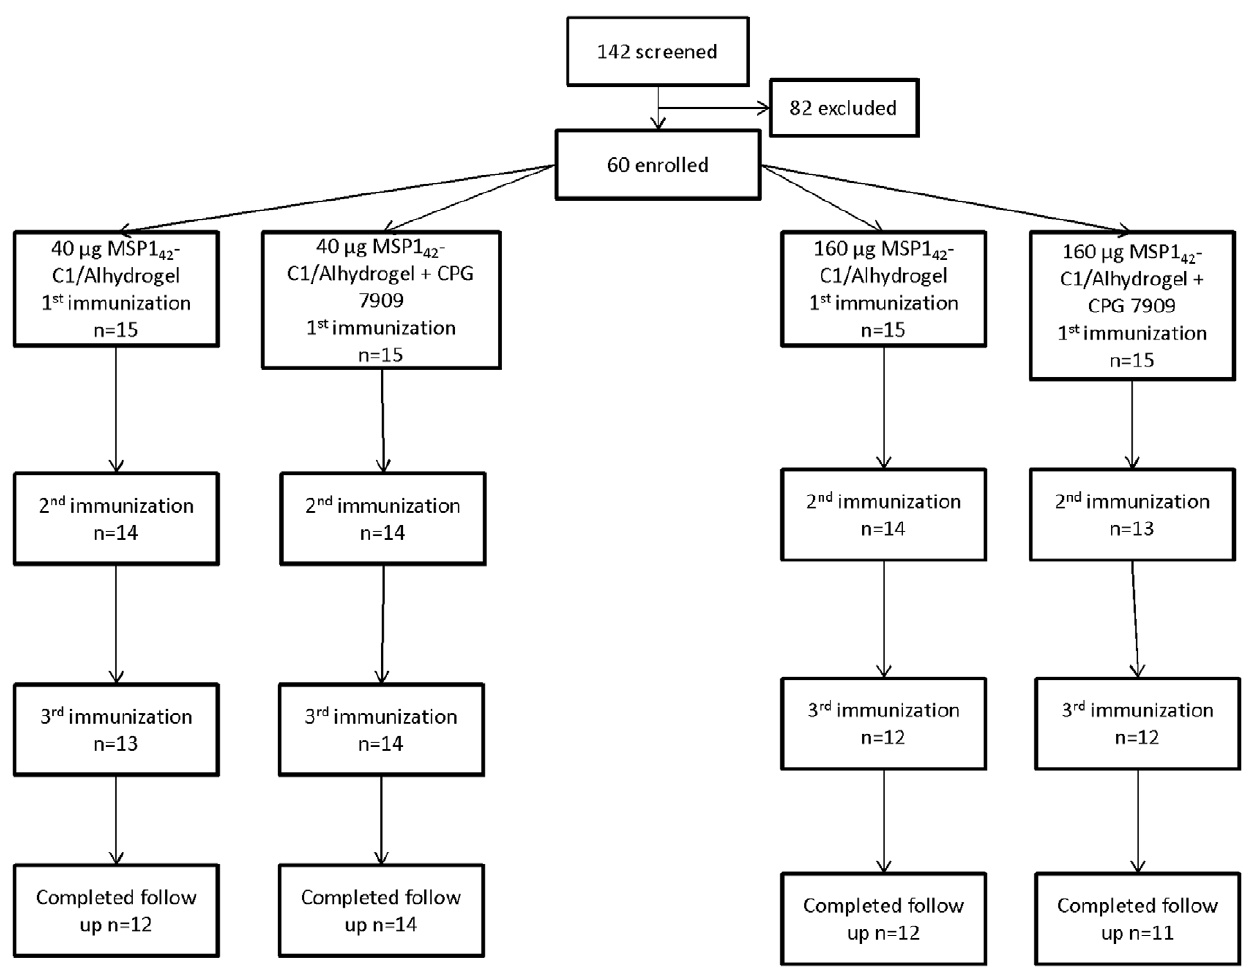
Figure 1. Flow chart of vaccinations and volunteer participation.